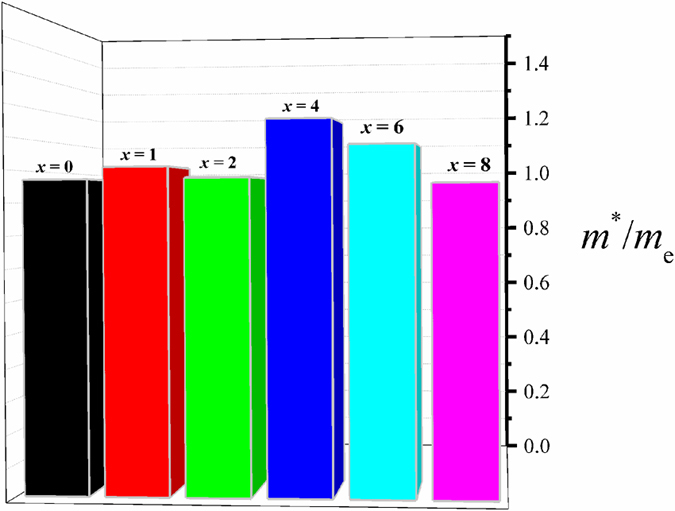
Calculated effective mass for the Cu15SxSe8−x (x = 0, 1, 2, 4, 6, 8) compounds.